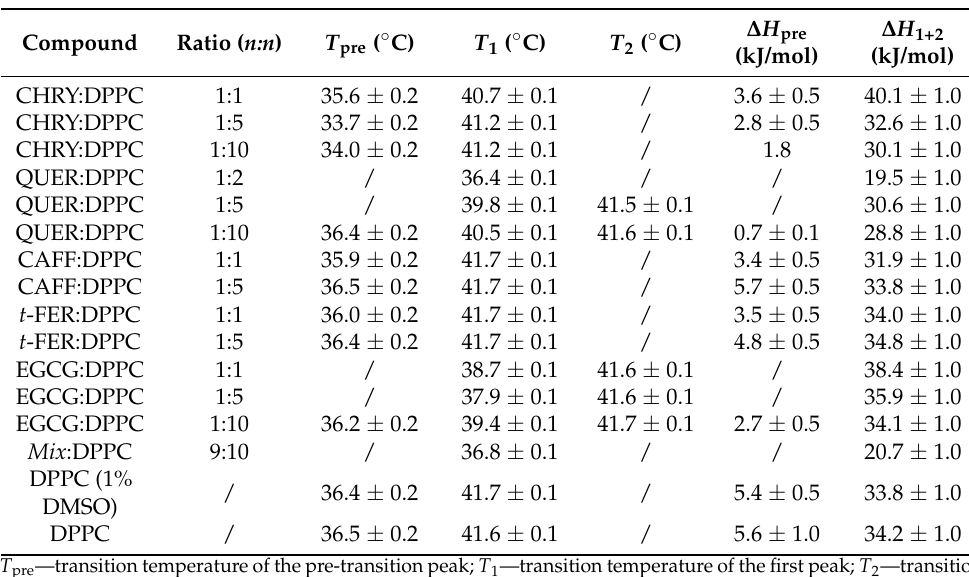
Table 2. The thermodynamic profile of the 1,2-dipalmitoyl- sn -glycero-3-phosphocholine lipids (MLV) at pH 7.0, at different molar ratios ( n:n ) of chrysin, quercetin, caffeic acid, trans -ferulic acid, (-)-epigallocatechin-3-gallate, and their mixture.